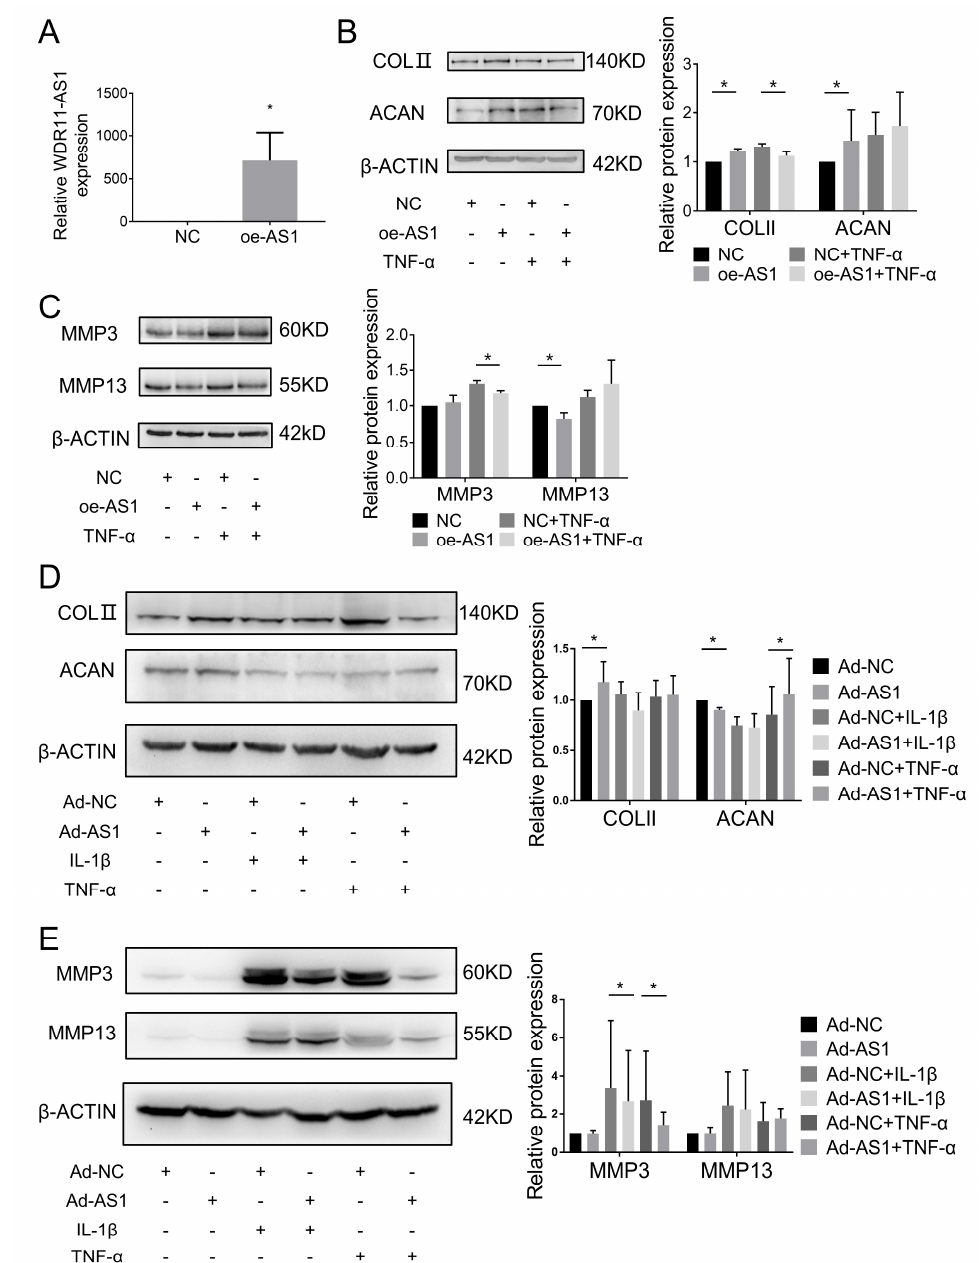
Figure 3. Overexpression of lncRNA WDR11-AS1 inhibits ECM degradation in chondrocytes. ( A ) Expression of lncRNA WDR11-AS1 was determined by RT-qPCR in SW1353 cells transfected with pEGFP-C1-WDR11-AS1 plasmid (oe-AS1, overexpression of lncRNA WDR11-AS1). ( B , C ) Western blot analysis showed COLII, ACAN ( B ), MMP3 and MMP13 ( C ) protein in TNF-α (10 ng/mL)-stimulated SW1353 cells after WDR11-AS1 overexpression. ( D , E ) Western blot analysis showed COLII ACAN ( D ), MMP3, and MMP13 ( E ) protein levels in IL-1β or TNF-α (10 ng/mL)-stimulated primary chondrocytes after WDR11-AS1 overexpression. * p < 0.05, oe -AS1 vs. NC ( A ); the measurement data are expressed as the mean ± standard deviation, and were analyzed by Mann–Whitney U test. The experiments were repeated three times.